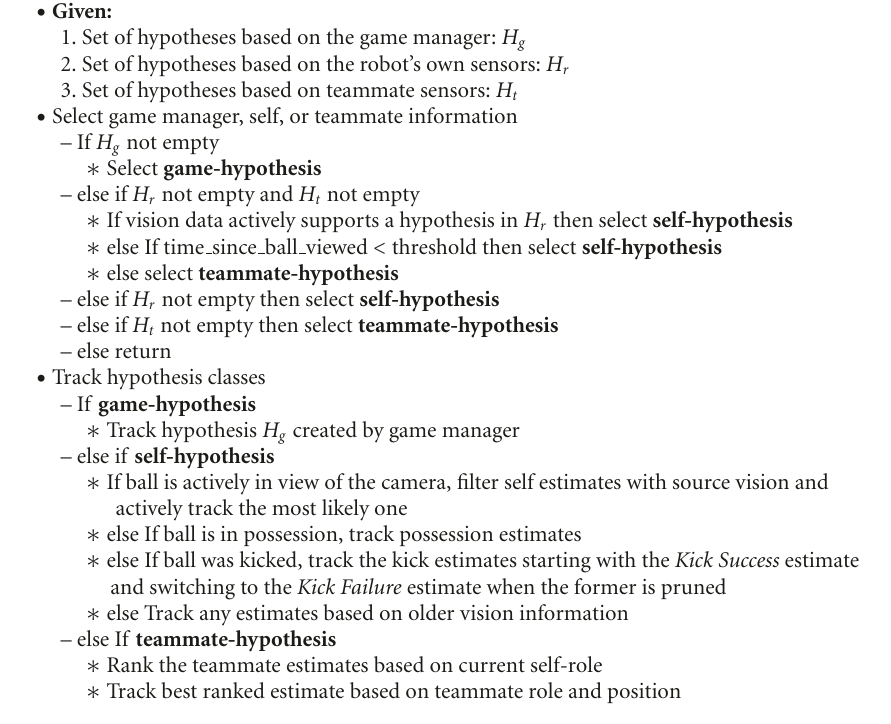
Algorithm 2: Hypothesis selection policy for ball tracking in AIBO Robot Soccer.